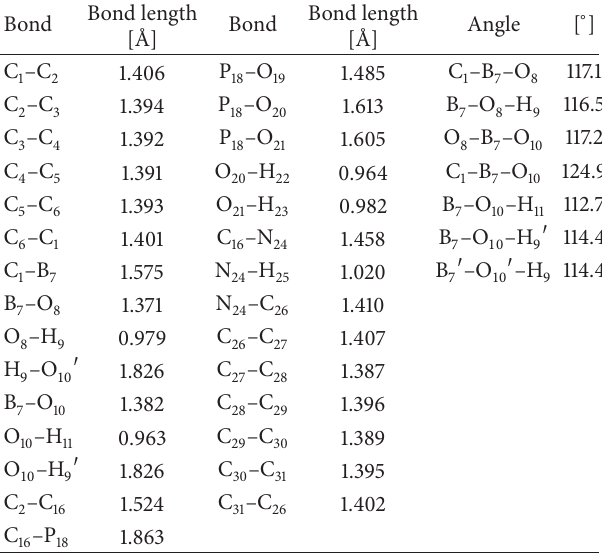
Table 1: Select calculated bond lengths and angles of the